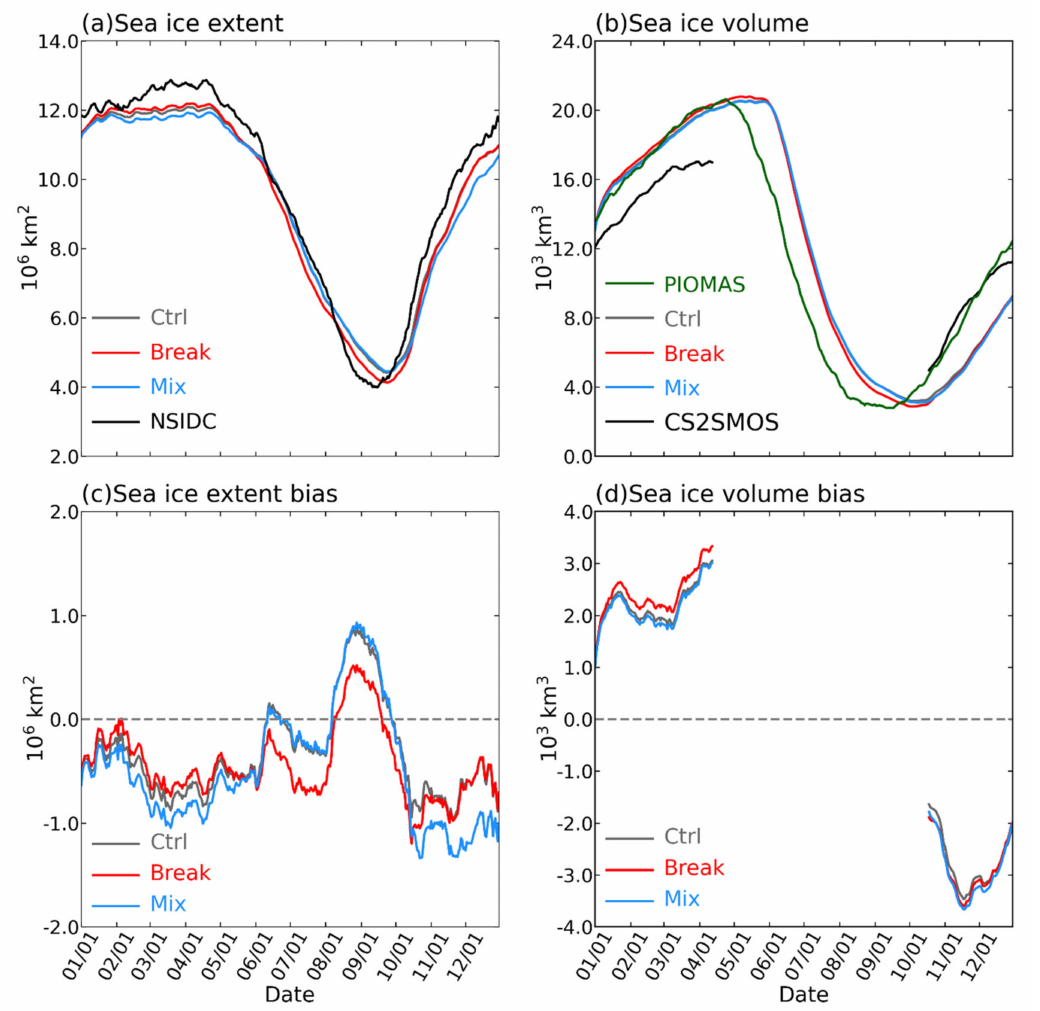
Figure 2. Daily evolution of sea ice extent ( a ) and sea ice volume ( b ) in the model domain from models and observations. ( a ) Ctrl, Break, Mix and NSIDC are indicated with the gray, red, blue and black lines, respectively. ( b ) Same as ( a ), but the black line for CS2SMOS and green line for PIOMAS. ( c , d ) Same as ( a , b ), but for the biases between model and observations from NSIDC sea ice extent and CS2SMOS sea ice